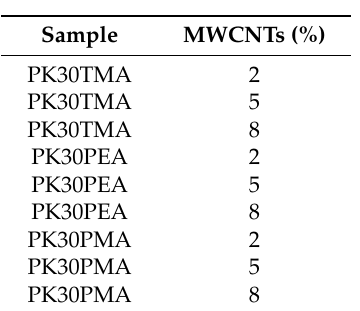
Table 1. Experimental conditions of functionalized PKs mixed with different wt % of multiwalled carbon nanotubes